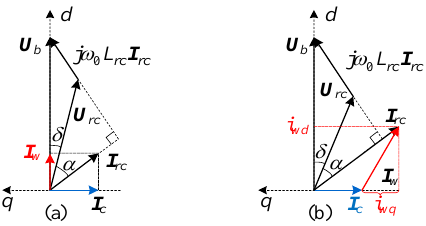
Figure 6. Vector diagrams under the condition that U b remains constant. ( a ) A smaller active current i wd (or P w ); ( b ) a larger active current i wd i wd (or P w ); ( b ) a larger active current i wd .